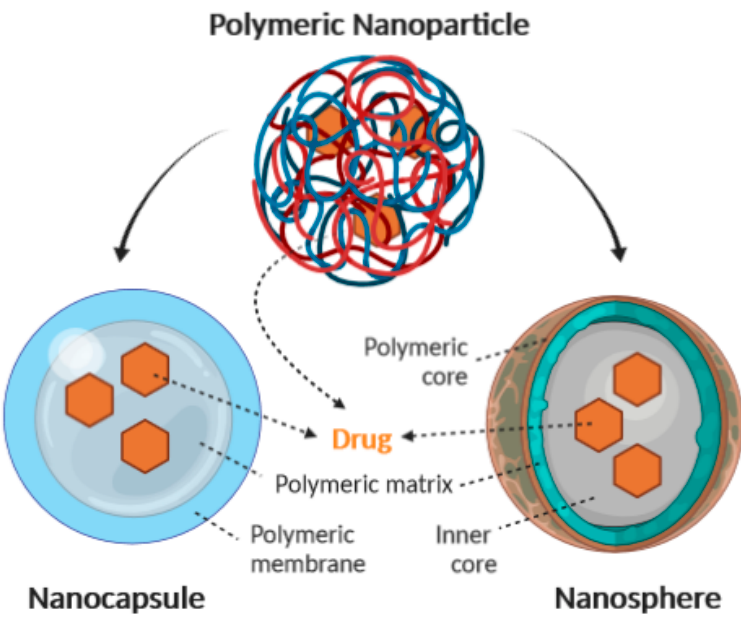
Figure 1. Schematic representation of the structure of nanocapsules and nanospheres (arrow stands for the presence of drug / bioactive within the nanoparticles). Table 1. Examples of drugs / bioactive ingredients loaded in polymeric nanoparticles. Type of Polymers